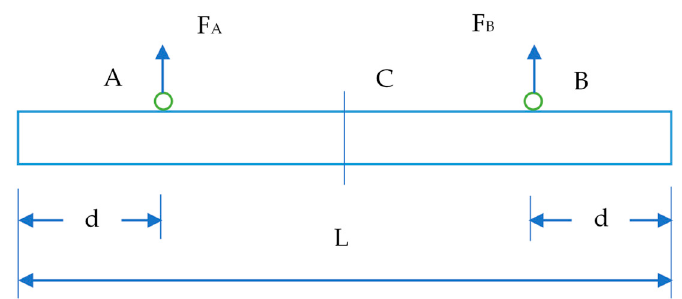
Figure 19. The mechanical model of setting lifting points for a PC wall.